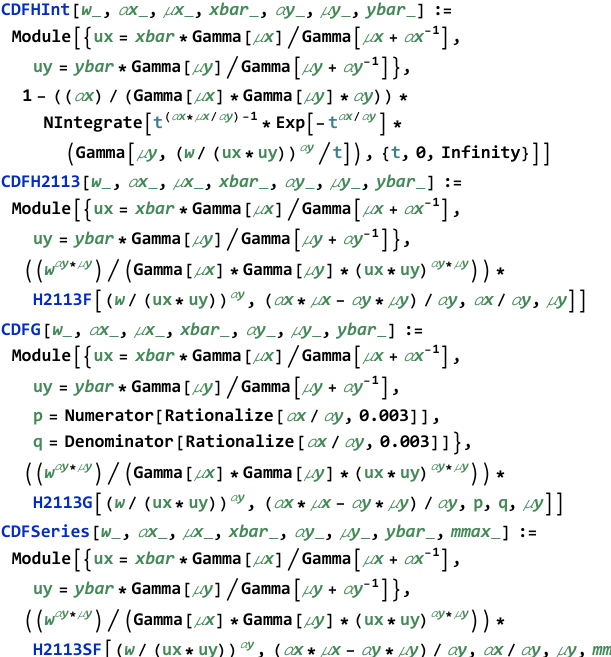
Figure 5. Algorithms used to implement the CDFs used in the present